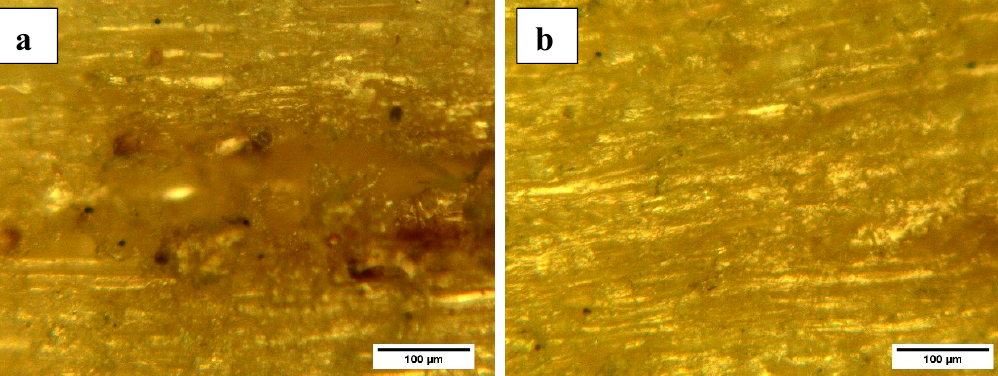
Figure 18. Micrographs of the breaking zone of specimen A3 by the speckled zone that was generated at 45°; the consecutive jumps of the fibers are observed. Figures 19–22 show the macrographic studies of the four control specimens (A3, A10, B6, and B11) of both trees, in comparison with the last frame of structural integrity. In the specimens A3, A10, and B6, the typical 45° breakage of the wood is observed. Whereas in A3 (Figure 19) the break occurred in the middle of the piece, in both A10 and B6 it was located in the upper portion. Specimen A3 shows the least resistance, but also underwent a central break at 45°, as shown by the last frame of the piece with structural integrity (without break). Specimens A10 (Figure 20) and B6 (Figure 21) show similar values in terms of compressive strength parallel to the fibers. The macrographic study fully coincides with the resistant behavior offered by the samples: the breaks were similar and both broke in the upper area at 45° angles but with less clarity than in the first case. The last frame shows the upper break, in addition to a mixture of the breaks of the four faces. There was no apparent breakage of the specimen B11 (Figure 22), although it underwent crushing, because this specimen was selected from the sapwood area of the trunk, which presents higher compressive strengths than the middle and heartwood areas (A3, A10, and B6) [47]. Each case is compared with the last frame in which there was integrity in the specimen, i.e., it maintained its shape without breaking. It can be seen how the use of the DIC roughly predicts the break zone a few milliseconds before the sample breaks. In the case of the test piece B11, the forces are distributed along the length of the test piece and, at the end, it recovers, maintaining its parallelepiped shape.